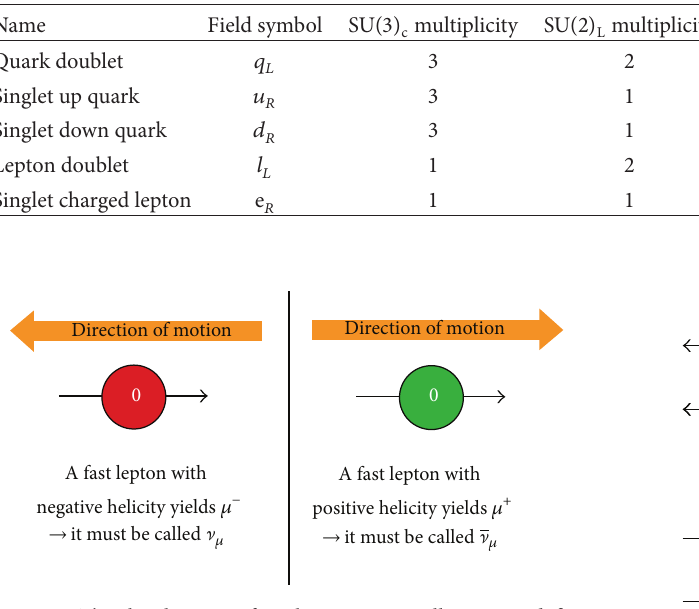
Figure 3: The chiral nature of weak interactions allows us to define what is a neutrino and what is an antineutrino in the ultrarelativistic limit , when chirality coincides with helicity and the value of the mass plays only a minor role.